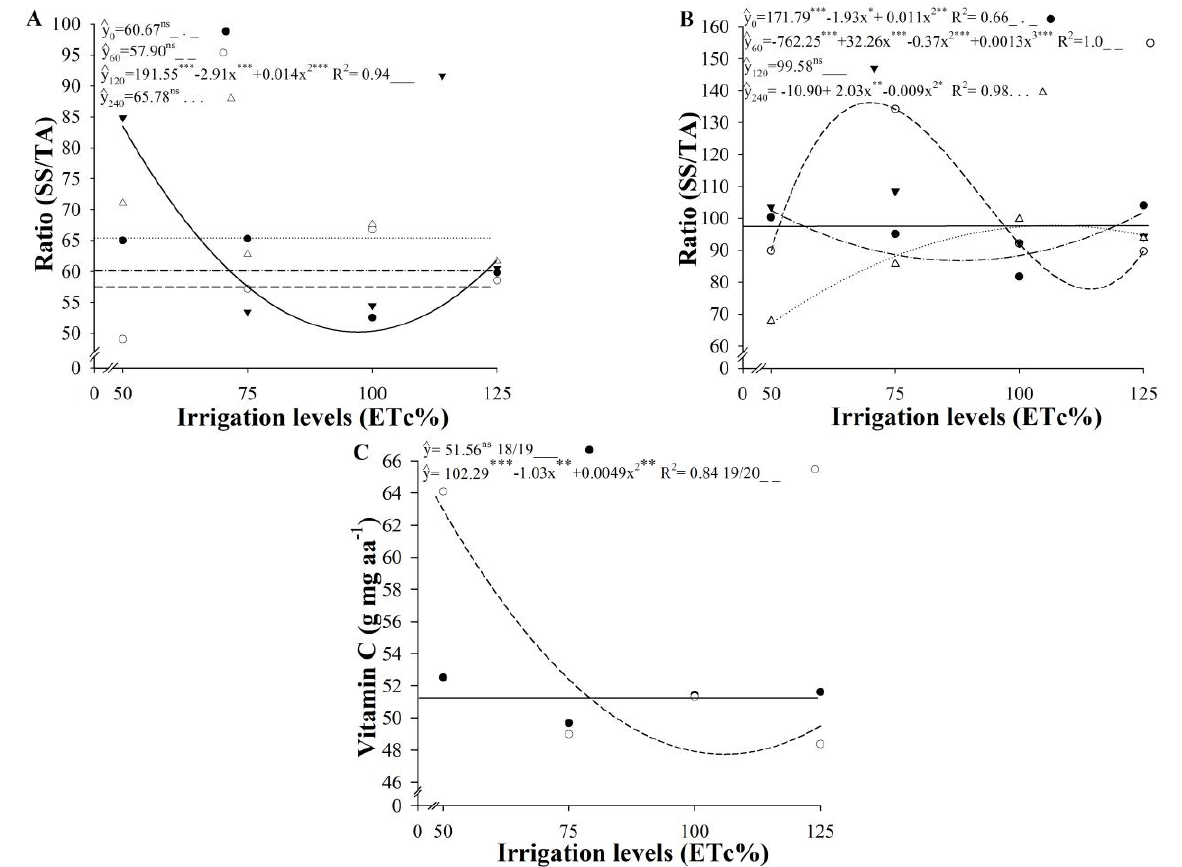
Figure 10. SS/TA ratio (( A ) — 2018/2019; ( B ) — 2019/2020) and vitamin C ( C ) of fig fruits as a function of irrigation levels under semiarid conditions. * Significant ( p < 0.05); ** Significant ( p < 0.01); *** Significant ( p < 0.001); ns Not significant ( p > 0.05). Means of 2 crop years (2018/2019 and 2019/2020).